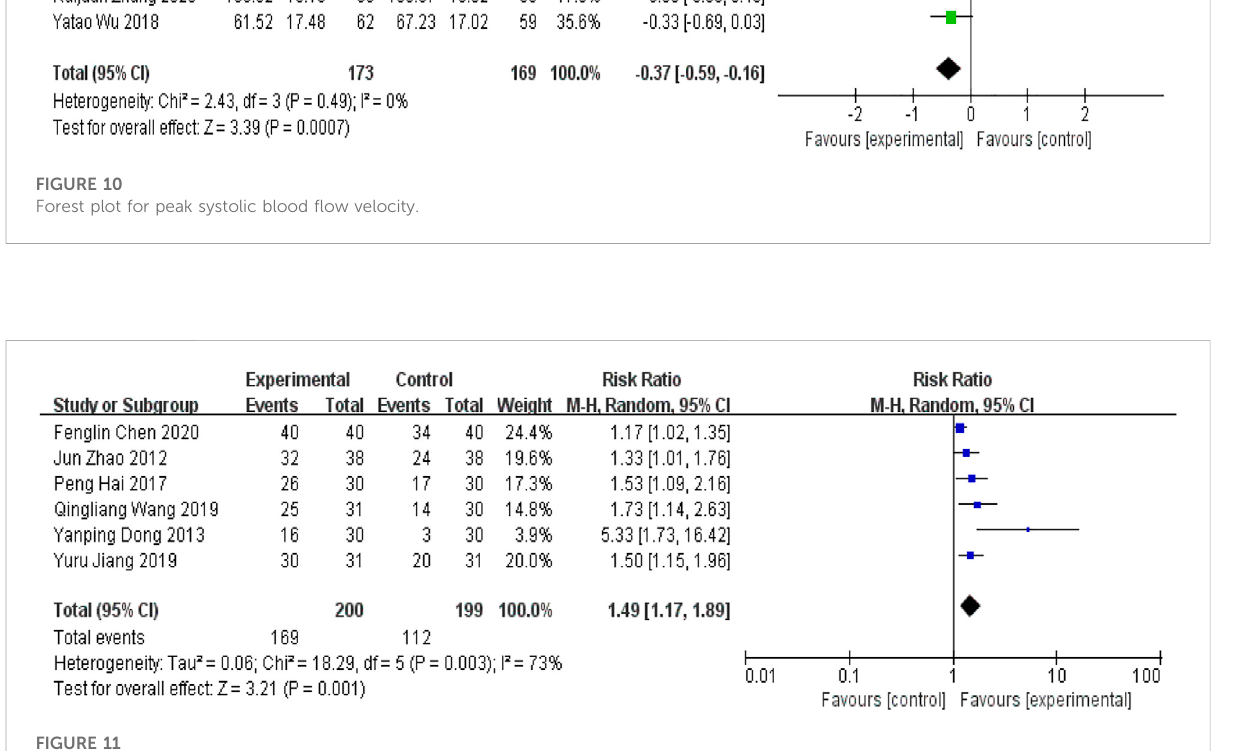
FIGURE 11 Forest plot for clinical ef fi cacy of Chinese